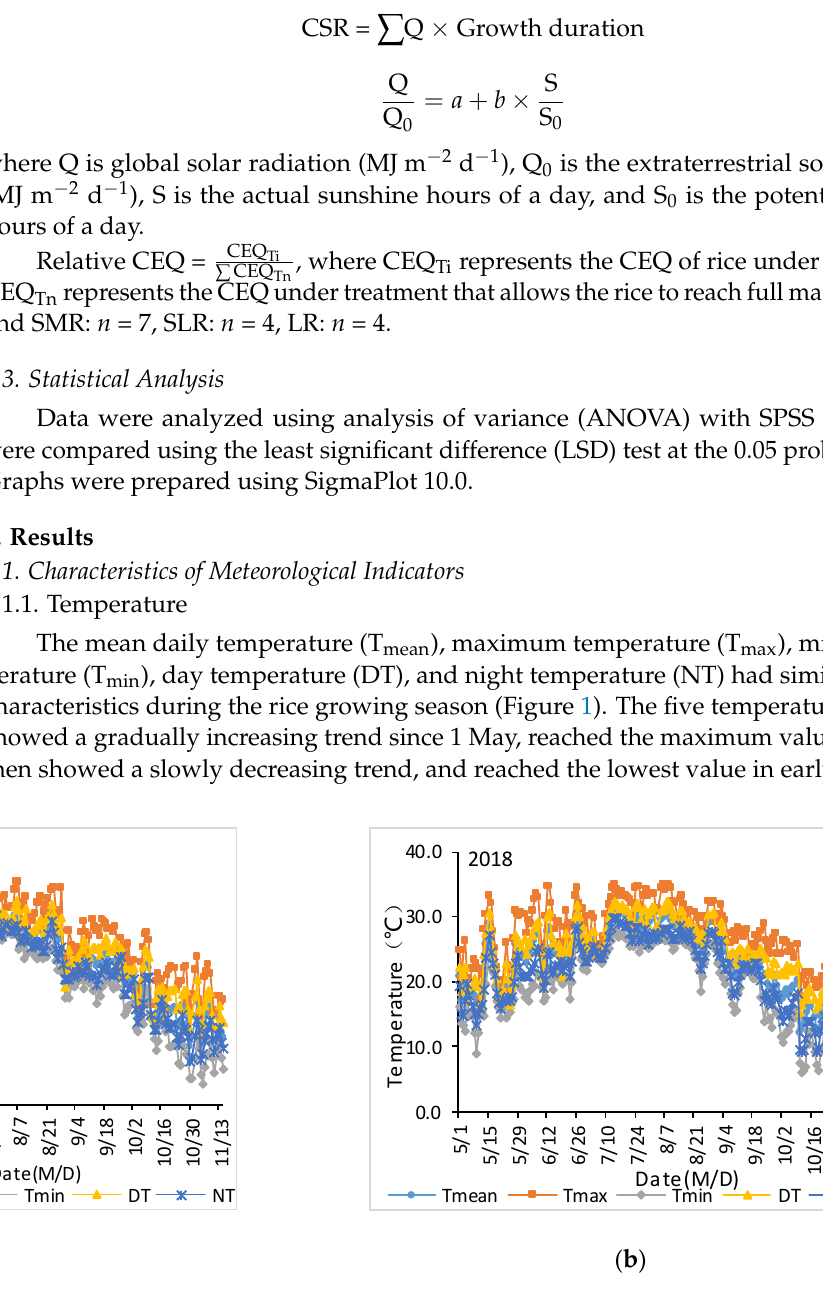
Figure 1. Daily temperature variation during the rice growing season. T mean , The mean daily temperature; T max , maximum temperature; T min , minimum temperature; DT, day temperature; NT, night temperature. ( a ): 2017; ( b ): 2018.